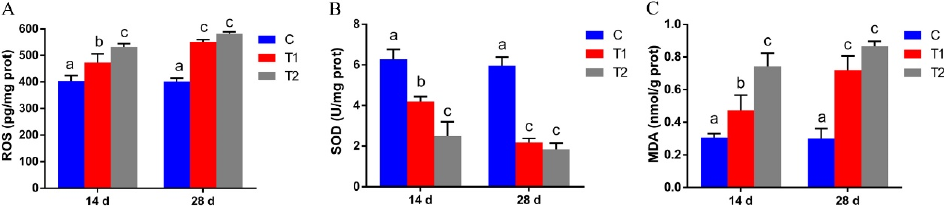
Figure 1. Reactive oxygen species (ROS; ( A )), superoxide dismutase (SOD; ( B )), and malondialdehyde (MDA; ( C )) activity in gibel carp liver after exposure to aflatoxin B1 (AFB1) for 14 and 28 days. C: control diet, T1: 50 µg/kg AFB1, T2: 100 µg/kg AFB1. Results are presented as mean ± standard deviation (SD). Dissimilar superscript letters represent statistically significant differences between different treatment groups ( p < 0.05).